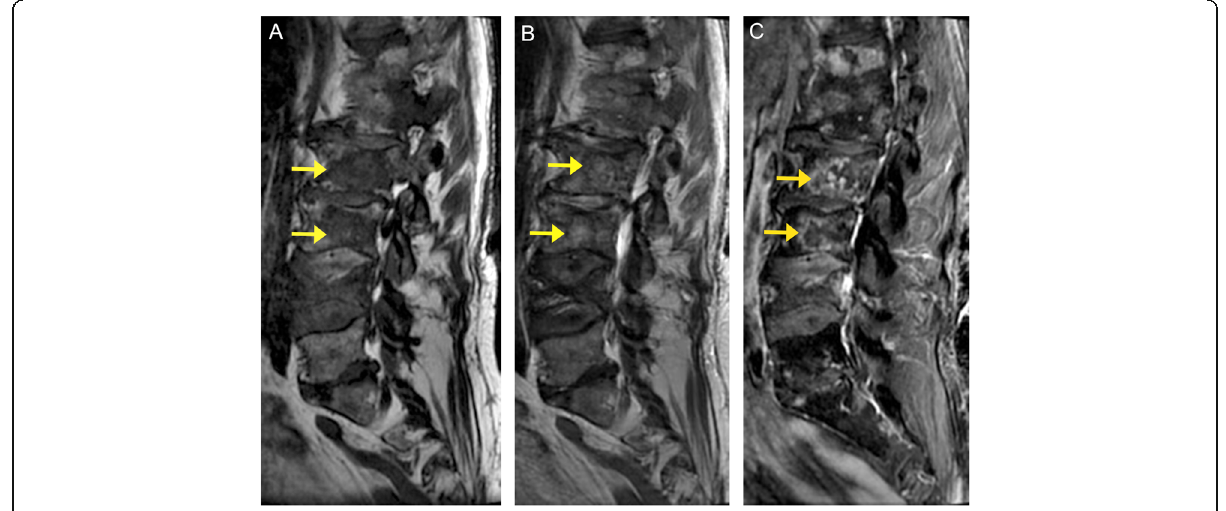
Fig. 14 Spinal metastases. Sagittal MR images demonstrate numerous ill-defined lesions throughout the lumbar spine (arrows). These lesions demonstrate low signal on the T1-weighted sequence ( a ), intermediate to high signal on the T2 -weighted sequence ( b ), and heterogenous contrast enhancement on the post-contrast T1 fat-saturated sequence ( c